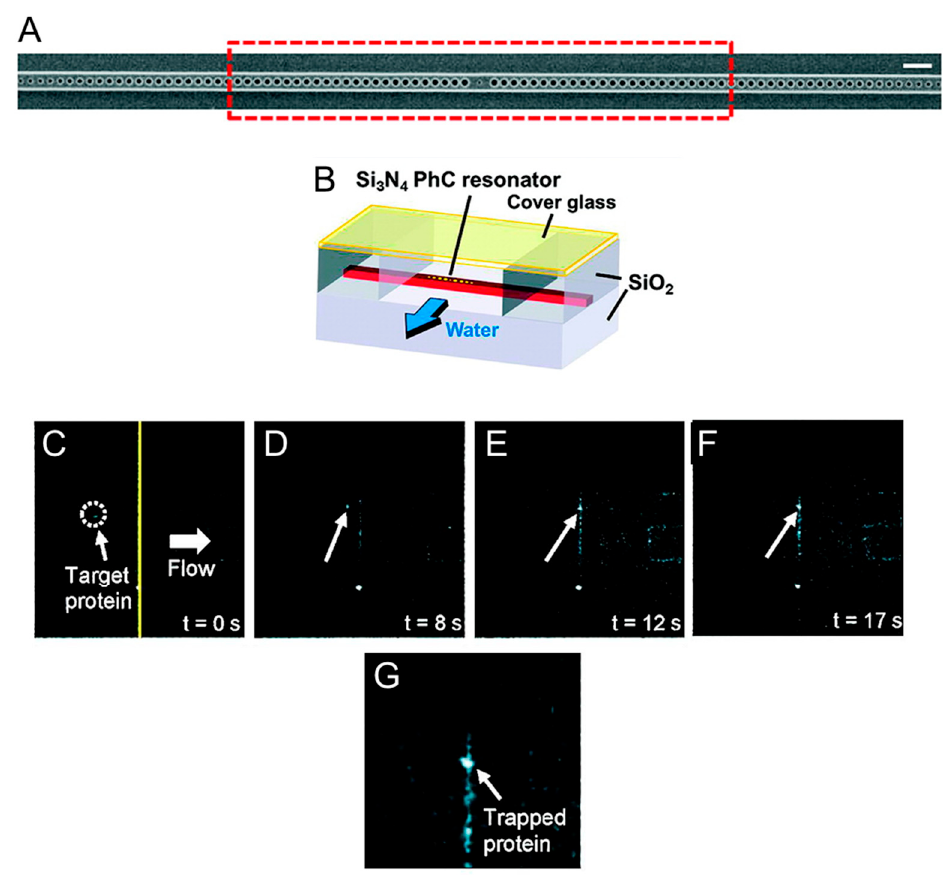
Figure 2. Trapping of individual proteins with a photonic crystal resonator. ( A ) Scanning electron microscope image of the silicon nitrite photonic crystal resonator fabricated by Chen et al. [41] to trap nanometer-sized objects. The resonator consists of a central hole flanked by 53 holes on both sides and is operated at 1064 nm. Scale bar: 1 µ m. ( B ) Schematic of the flow chamber used to flow protein molecules near the resonator. ( C – F ) Fluorescence microscope images of Cy5-labeled Wilson disease proteins inside the flow chamber. As the flow is activated ( t = 0 s), the proteins that are conveyed near the optically excited resonator remain stably trapped. A high-resolution picture of a group of trapped proteins is shown in ( G ). Adapted with permission from [41]. Copyright 2012 American Chemical Society.